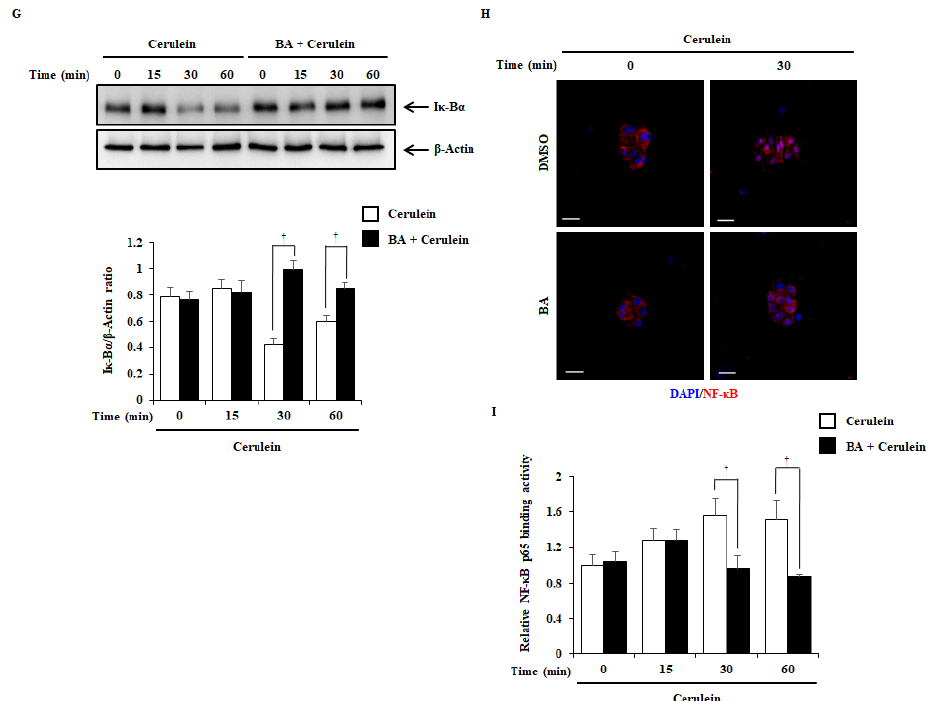
Figure 5. Effect of betulinic acid (BA) on nuclear factor-kappa B (NF- κ B) activation. ( A ) Mice were pretreated for 1 h with BA (10 mg/kg) or dimethyl sulfoxide (DMSO). The mice were then injected with cerulein (50 µ g/kg) and sacrificed at 0, 15, 30, or 60 min. Confocal images of immunofluorescence staining of ( B ) phosphorylated I κ B kinase (pIKK α / β , red), ( C ) phosphorylated inhibitory κ -B α (pI κ -B α , red), ( D ) I κ -B α (red) and DAPI (blue). Scale bar = 20 µ m. ( E ) Degradation of I κ -B α was measured using western blotting. β -Actin was used as the loading control. The western blot of I κ -B α was quantified by densitometry and normalized to β -Actin. ( F ) NF- κ B p65 binding activity was measured in the pancreas. ( G ) Pancreatic acinar cells (PACs) were pretreated with BA (10 µ M) for 1 h and then stimulated with cerulein (10 nM) for the indicated times. Degradation of I κ -B α was measured using western blotting. β -Actin was used as the loading control. The western blot of I κ -B α was quantified by densitometry and normalized to β -Actin. ( H ) Immunofluorescence staining of NF- κ B p65 (red) and DAPI (blue) in PACs. Scale bar = 20 µ m. ( I ) NF- κ B p65 binding activity was measured in PACs. Data are represented as mean ± SEM for six mice in each group. Results are representative of three experiments. † p < 0.05 vs. cerulein treatment